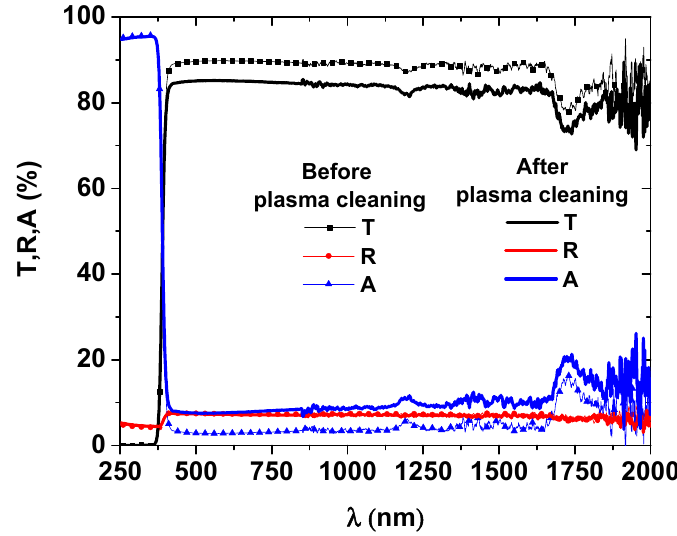
Figure 3. Spectrophotometric curves of the polymer foil sample before and after plasma cleaning at 50 V for 15 min (T–transmittance, R–reflectivity, A–absorbance).